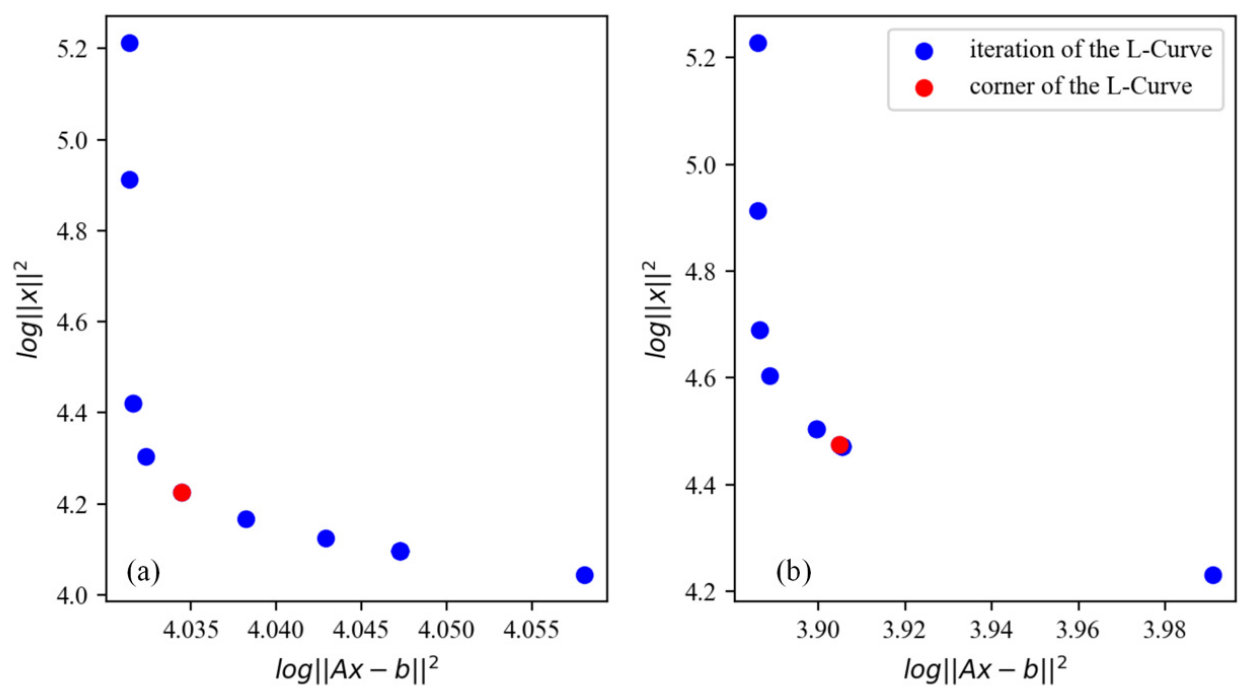
Figure 5. L-curve for ( a ) deformation velocity and ( b ) DEM error.